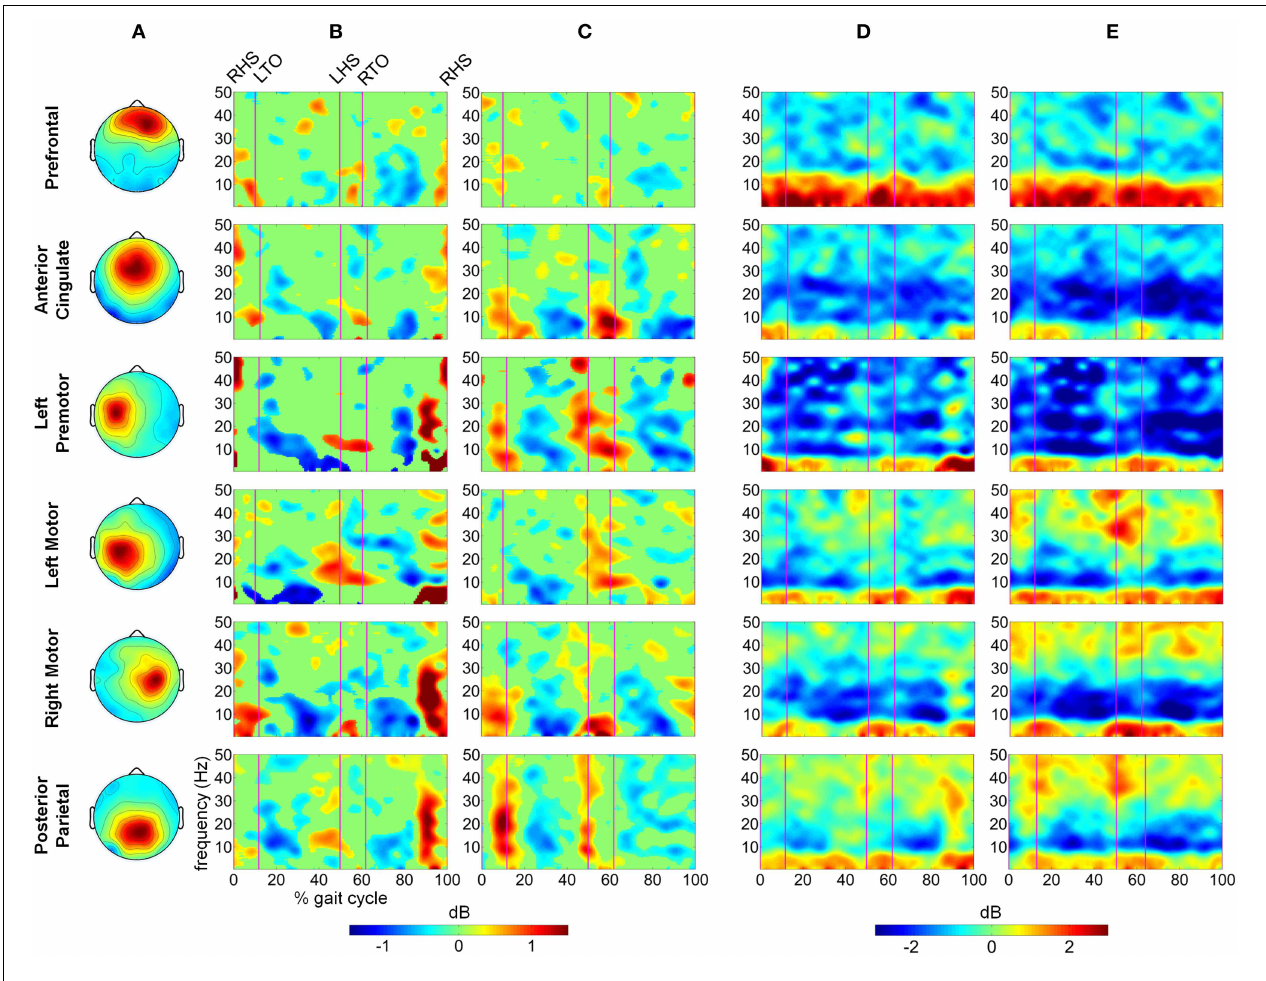
FIGURE 5 | Time frequency decomposition of cortical clusters during steady, slow treadmill walking. (A) The average topographical scalp projections of independent components comprising the six cortical clusters. Grand mean time frequency amplitude ratio to the mean gait cycle spectrum,